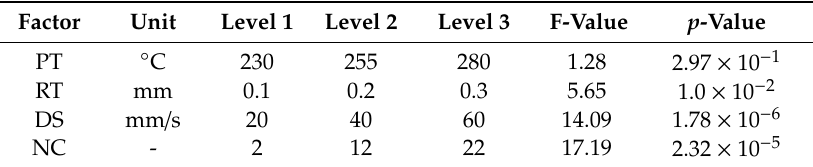
Table 7. ANOVA results for ULSF for ABS BM